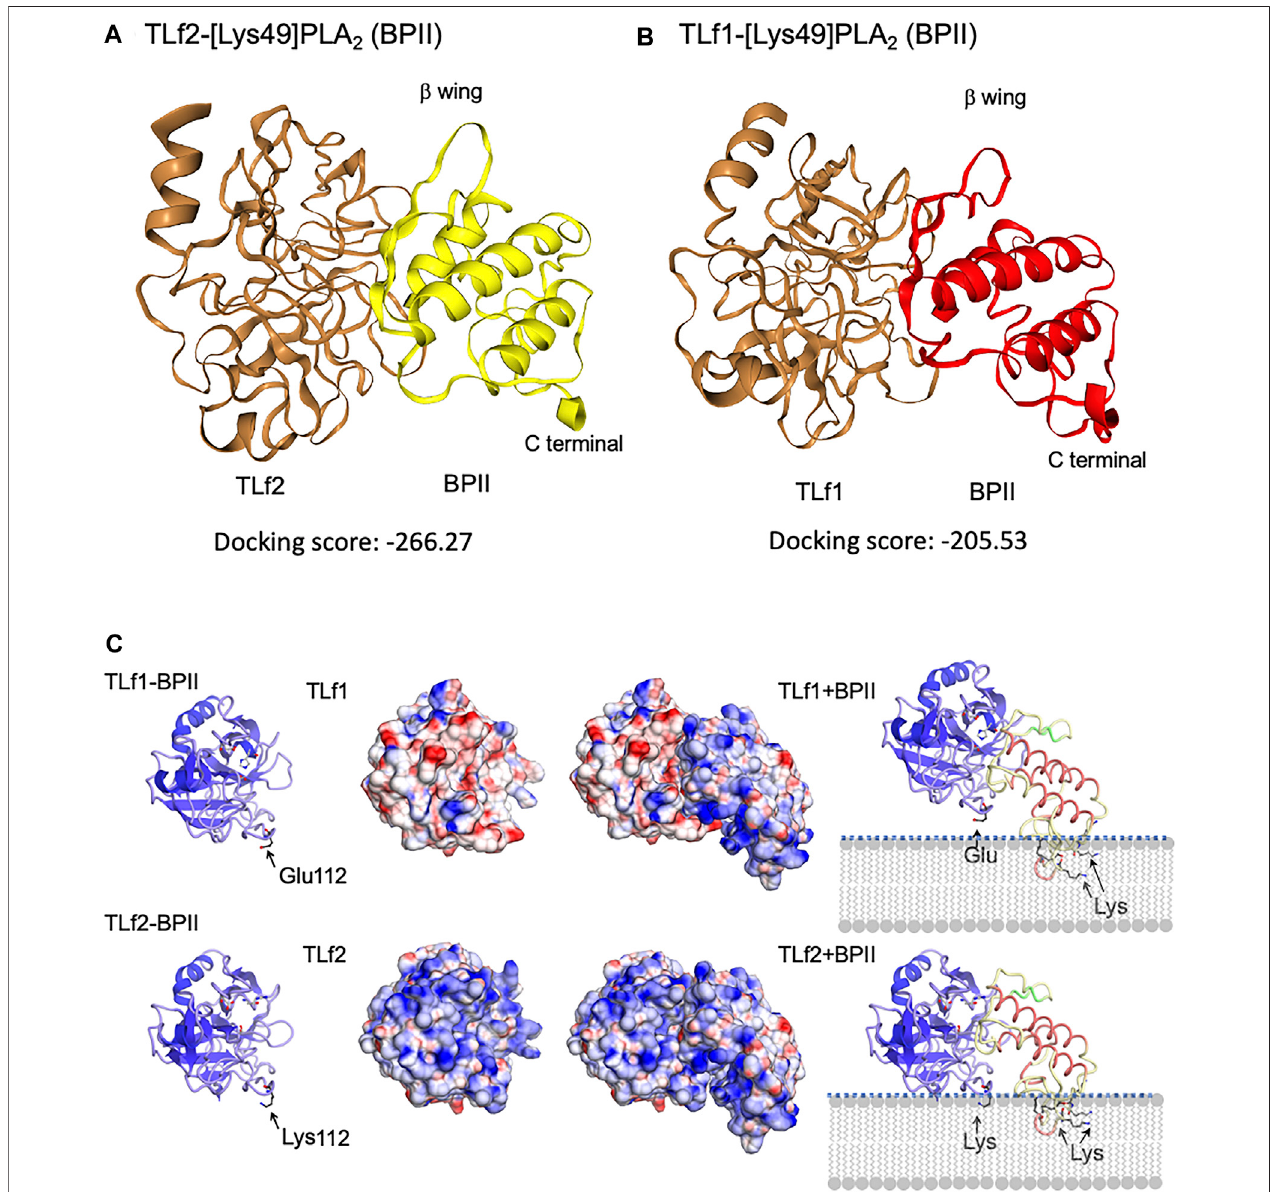
FIGURE 7 | Predicted 3D structures of complex of BPII and TLf2 (A) or TLf1 (B) , and the surface electric charge of complexes, TLf1-BPII and TLf2-BPII (C) . Complex structures were estimated by the protein-protein docking simulation using HDOCK server that based on hybrid docking strategies, template-based modeling and ab initio docking (Yan et al., 2020). 3D structures of TLf1 and TLf2 were predicted by homology modeling based on the complex 3D structure of trypsin and its inhibitor (PDB 1TX6), while [Lys49] PLA2 (BPII, PDB 6AL3) was used as a ligand molecule. Predicted models with the lower docking energy score, entry no.1 for TLf2 and entry no. 3 for TLf1 ( Supplementary Figure S6 ), were